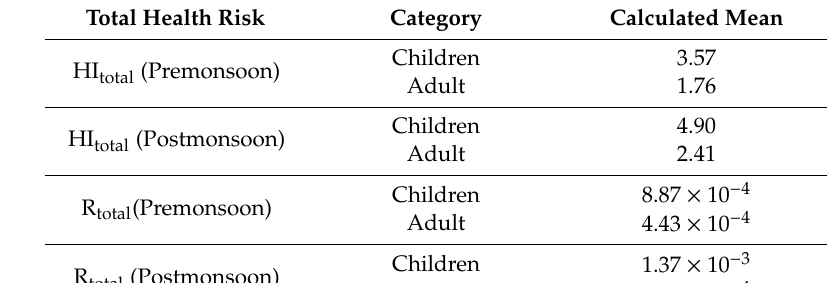
Table 6. HI total and total carcinogenic health risk (R total ).